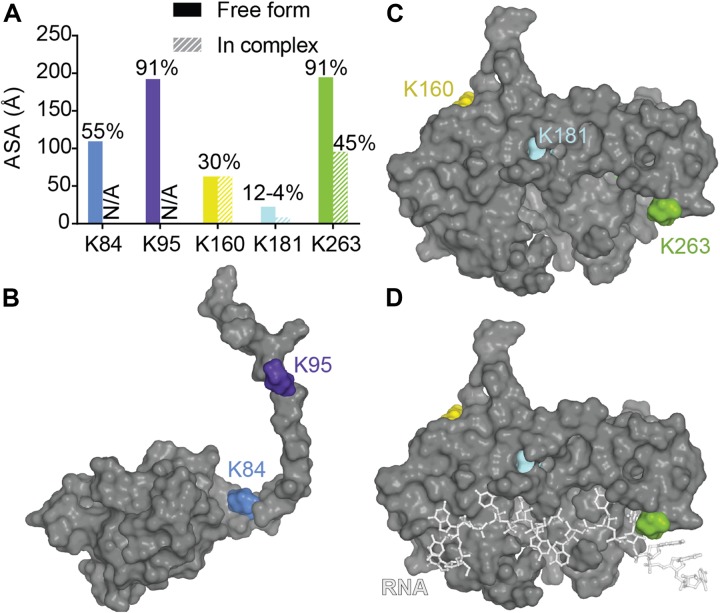
Ubiquitination of lysines in TDP-43. (A) Accessibility of the known ubiquitinated Lysine residues were calculated using Areaimol as implemented in the CCP4 suite (Otwinowski and Minor, 1997) on the NTD structure [PDB ID 5mrg (Mompeán et al., 2017), K84 and K95] or the tethered RRM domains structure [PDB ID 4bs2 (Lukavsky et al., 2013), K160, K181, and K263]. Mapping of the SUMOylation motifs on the surface of TDP-43 NTD (B) or RRM1-2 with and without RNA (C,D).